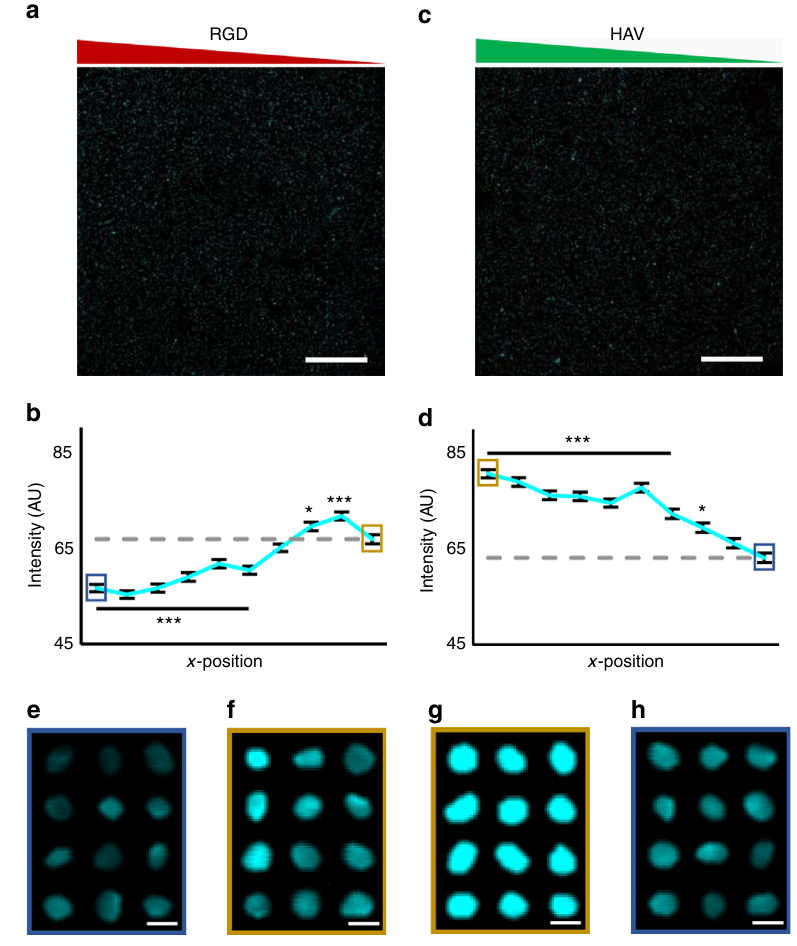
Fig. 2 Effects of HAV and RGD gradients on transcription factor Sox9 expression. Maximum projection images and quanti fi cation across 10 regions of nuclear Sox9 fl uorescence (aqua) for gradients of a , b RGD and c , d HAV peptides after 1 day. Representative maximum projection images of nuclei stained for Sox9 in e high or f low RGD regions and g high or h low HAV regions. Generally, higher nuclear Sox9 was observed with decreasing RGD and for increasing HAV. Error bars represent standard error around the mean (s.e.m.); n > 300 cells per zone, *** p < 0.001, * p < 0.05 compared to lowest peptide region (gray dashed line). Scale bars: a , c 1 mm, e – h 10 µ